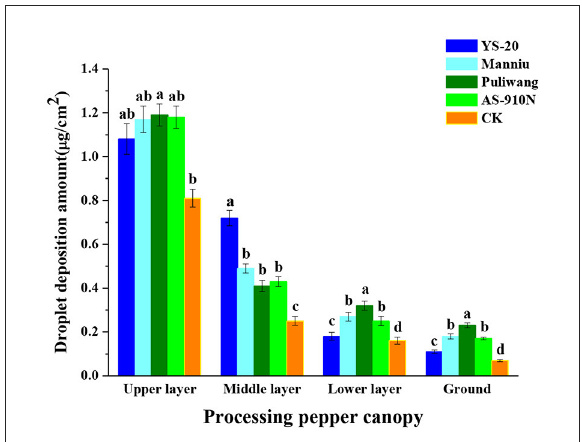
FIGURE8 Effect of aerial spray with adjuvants on the droplet distribution sprayed by UAV. a − d They represent the results of a significant difference analysis by Duncan’s new multiple range test at the level of P < 0.05. Values followed by the same letter do not differ